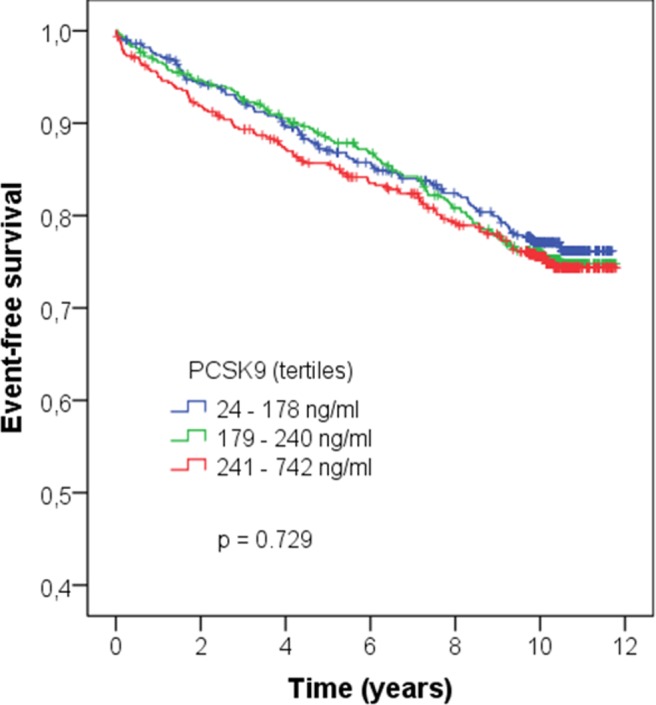
Association of PCSK9 tertiles with cardiovascular death in LURIC participants; Kaplan-Meier analysis followed by log-rank test.